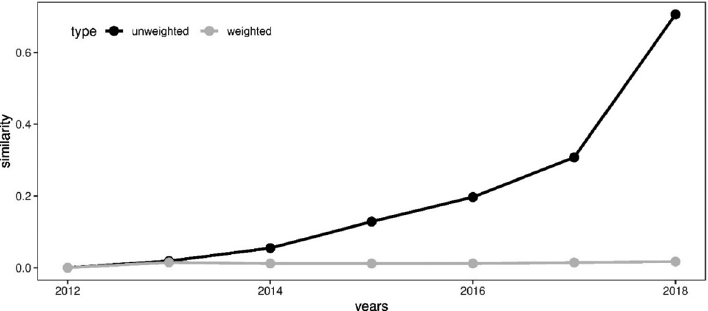
Figure 4. The similarity in tweets’ hashtags presence in both publications and tweets (2012–2018) (source: own study based on Web of Science, Scopus, and